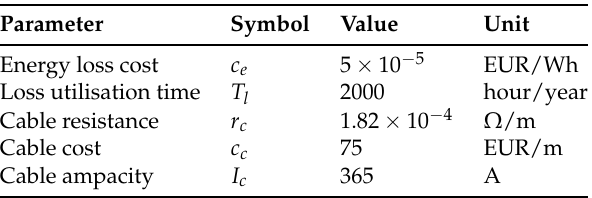
Table 1. Simulation parameters.